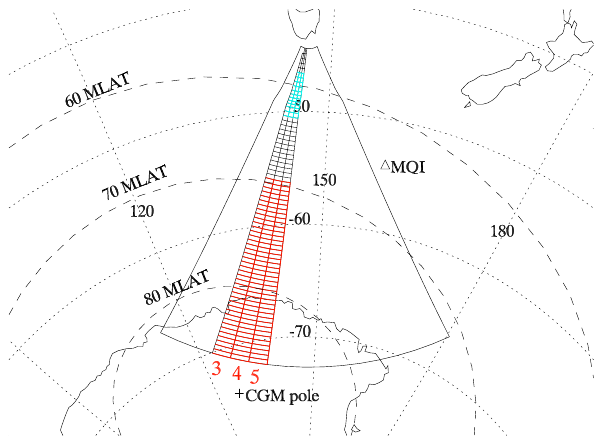
Fig. 1. TIGER beams 3, 4 and 5 used in this paper (mesh area). Dotted and dashed lines correspond to geographic and AACGM coordinates, respectively. Red- and cyan-coloured area shows re- spective range spans for F (gates 30–70) and E-region (gates 5–15) echoes analysed in this paper. Beam numbers are shown in